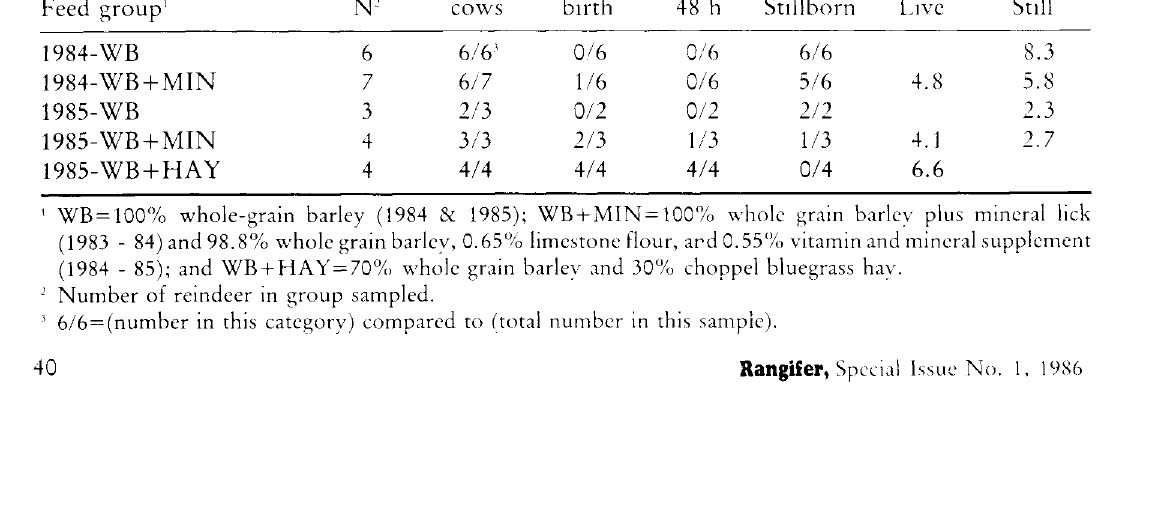
Table 2. The reproductive performance of reindeer fed all-grain and grain/hay